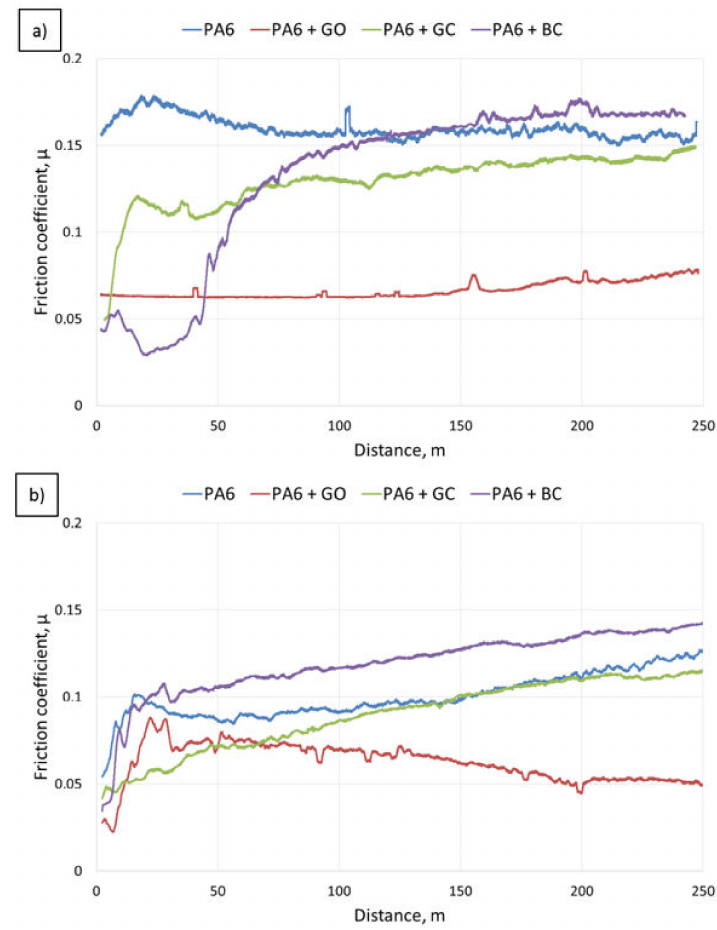
Figure 10. Changes in the coe ffi cient of friction determined with reciprocating movement for the composites and reference material over a distance of 250 m: ( a ) after injection, ( b ) after heat